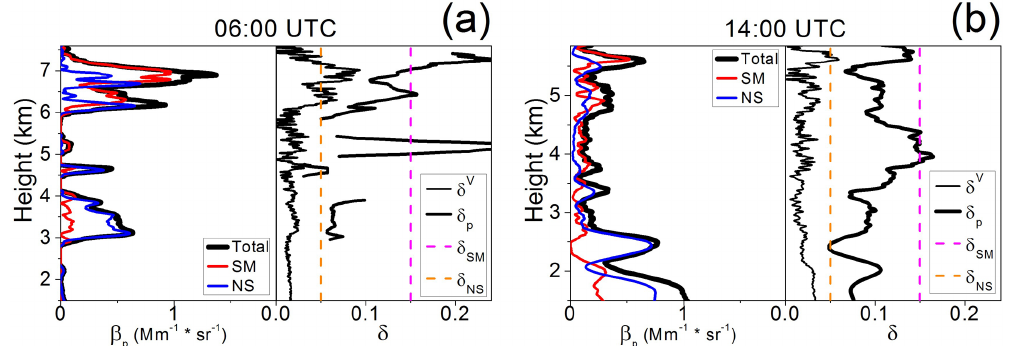
Figure 6. The same as Fig. 4 but for the smoke event on 23 May 2016 at (a) 06:00UTC, and (b) 14:00UTC. Specific depolarization ratios selected for each smoke aerosol component are also shown by vertical dashed lines (see legend for